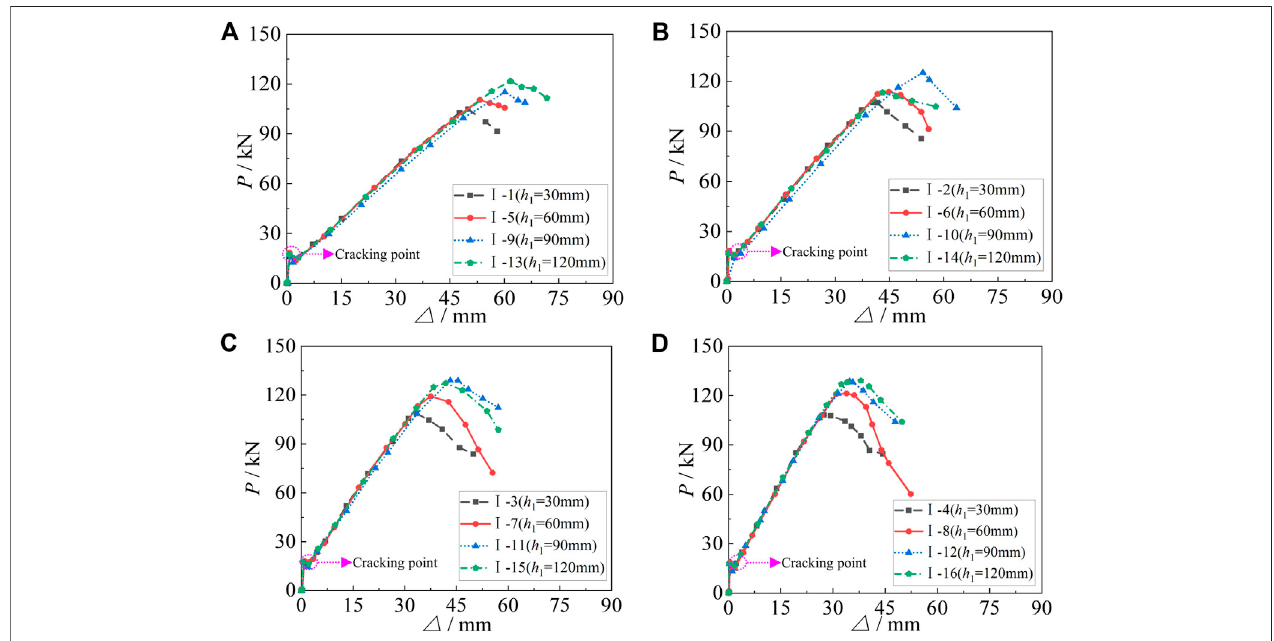
FIGURE11| Comparisonofload – displacementcurvesofsimplysupportedbeamswithdifferent h 1 : (A) ρ GFRP (cid:2) 1.14%; (B) ρ GFRP (cid:2) 1.49%; (C) ρ GFRP (cid:2) 1.88%; (D) ρ (cid:2) GFRP